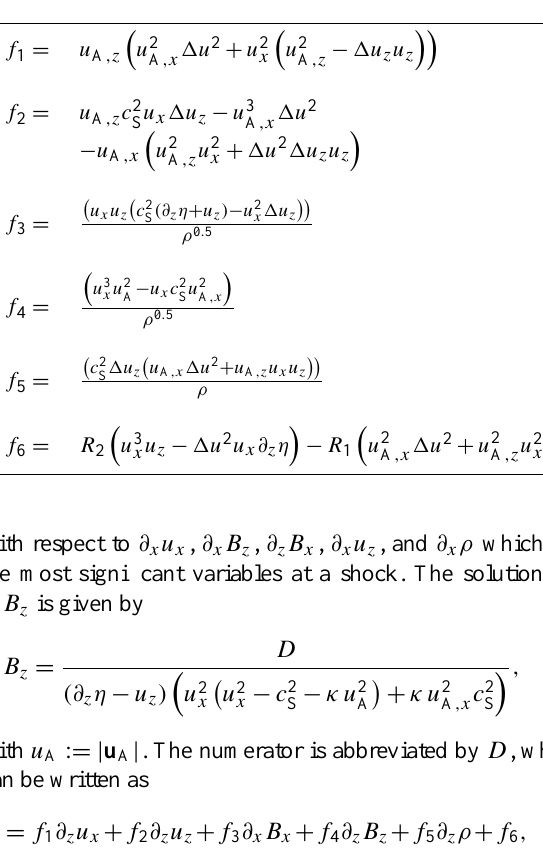
Table 1. The coefficients in Eq. (15) using (cid:49)u 2 := u 2 x − c 2 (cid:49)u z := u z − ∂ z η to simplify the